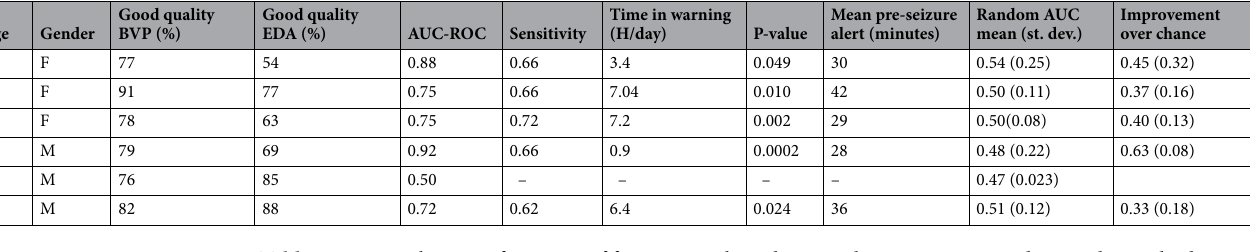
Table 2. Intra-subject performance of forecasting algorithm. P-values were computed using the method described by Snyder et al. 28 . The signal quality metrics were calculated according to techniques reported previously 27 and the percentage of the data with good quality was reported for EDA and BVP signals. Random AUC values were calculated by randomizing the seizure times for each subject and repeating the scoring 100 times for each subject. The sensitivity difference between results and random output was calculated at the same Time in Warning.